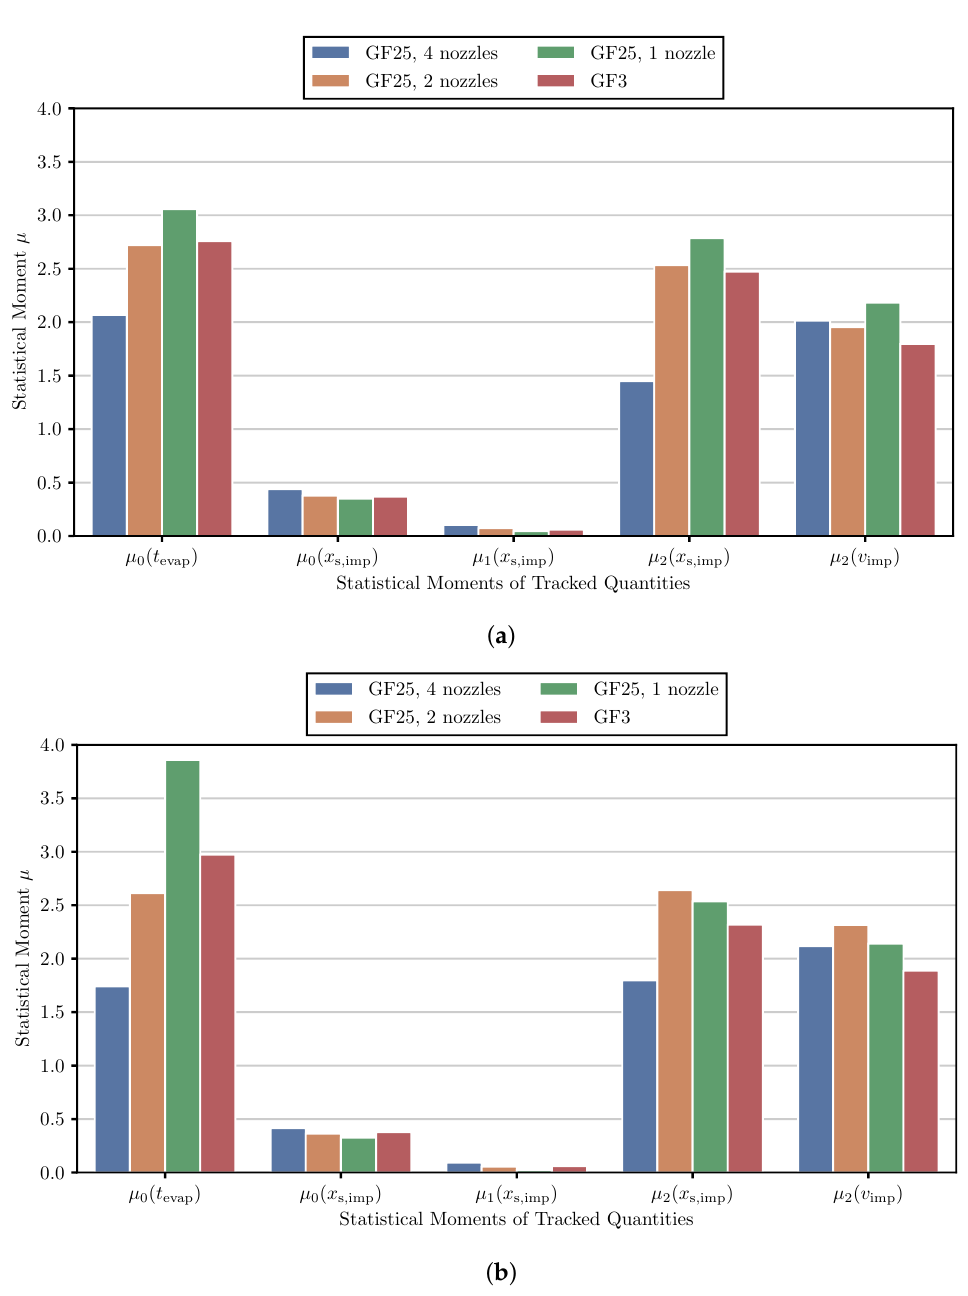
Figure 15. Tracked quantity distributions and their statistical moments for the lab-scale plant (GF3) and pilot-scale plant (GF25). ( a ) Statistical moments of tracked quantities at a spray rate of ˙ M spray = 8 15gmin − 1 . ( b ) Statistical moments of tracked quantities at a spray rate of × ˙ M 1 spray = 8 × 20gmin −